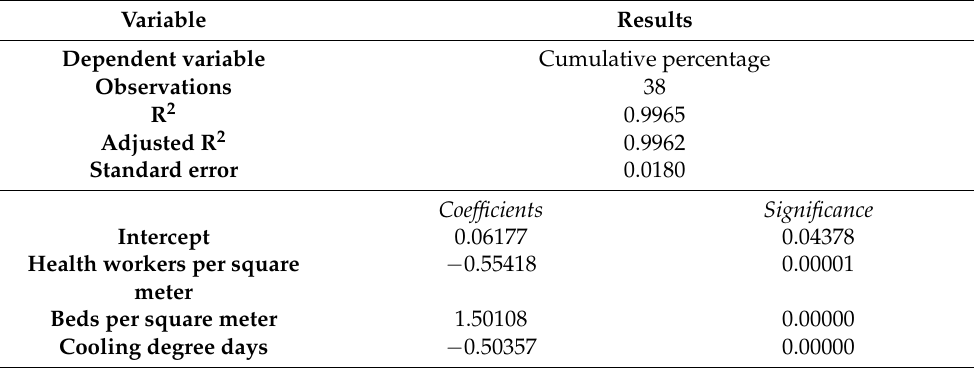
Figure 5. Cumulative distribution of the energy efficiency ratios. Table 6. Regression analysis results for the cumulative percentage.